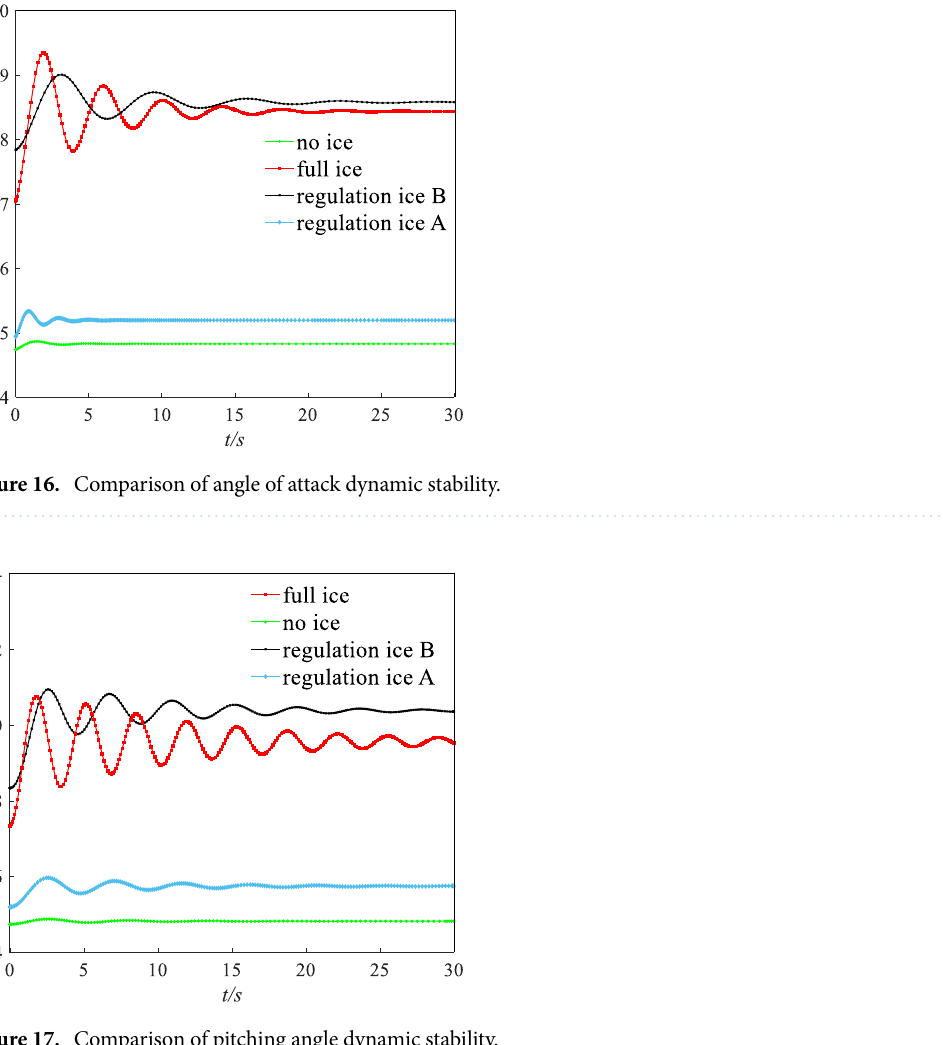
Figure 17. Comparison of pitching angle dynamic stability.